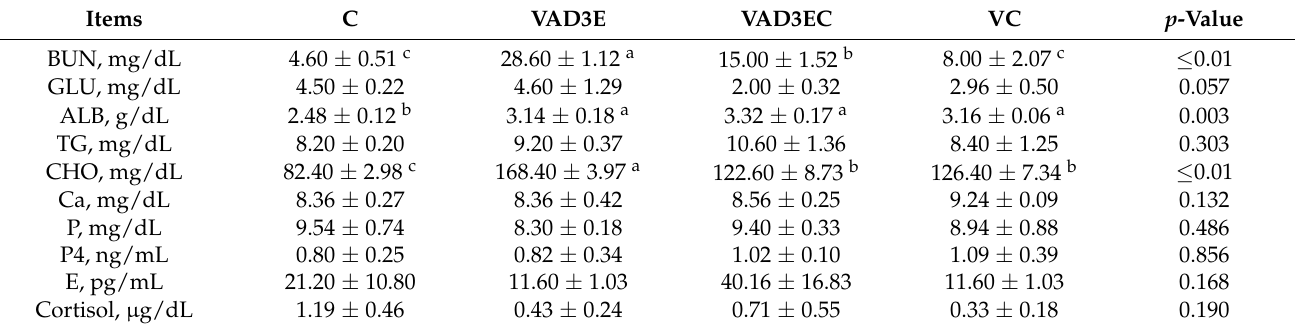
Table 4. Effects of various vitamins on biochemical parameters of serum in dairy cows over 14